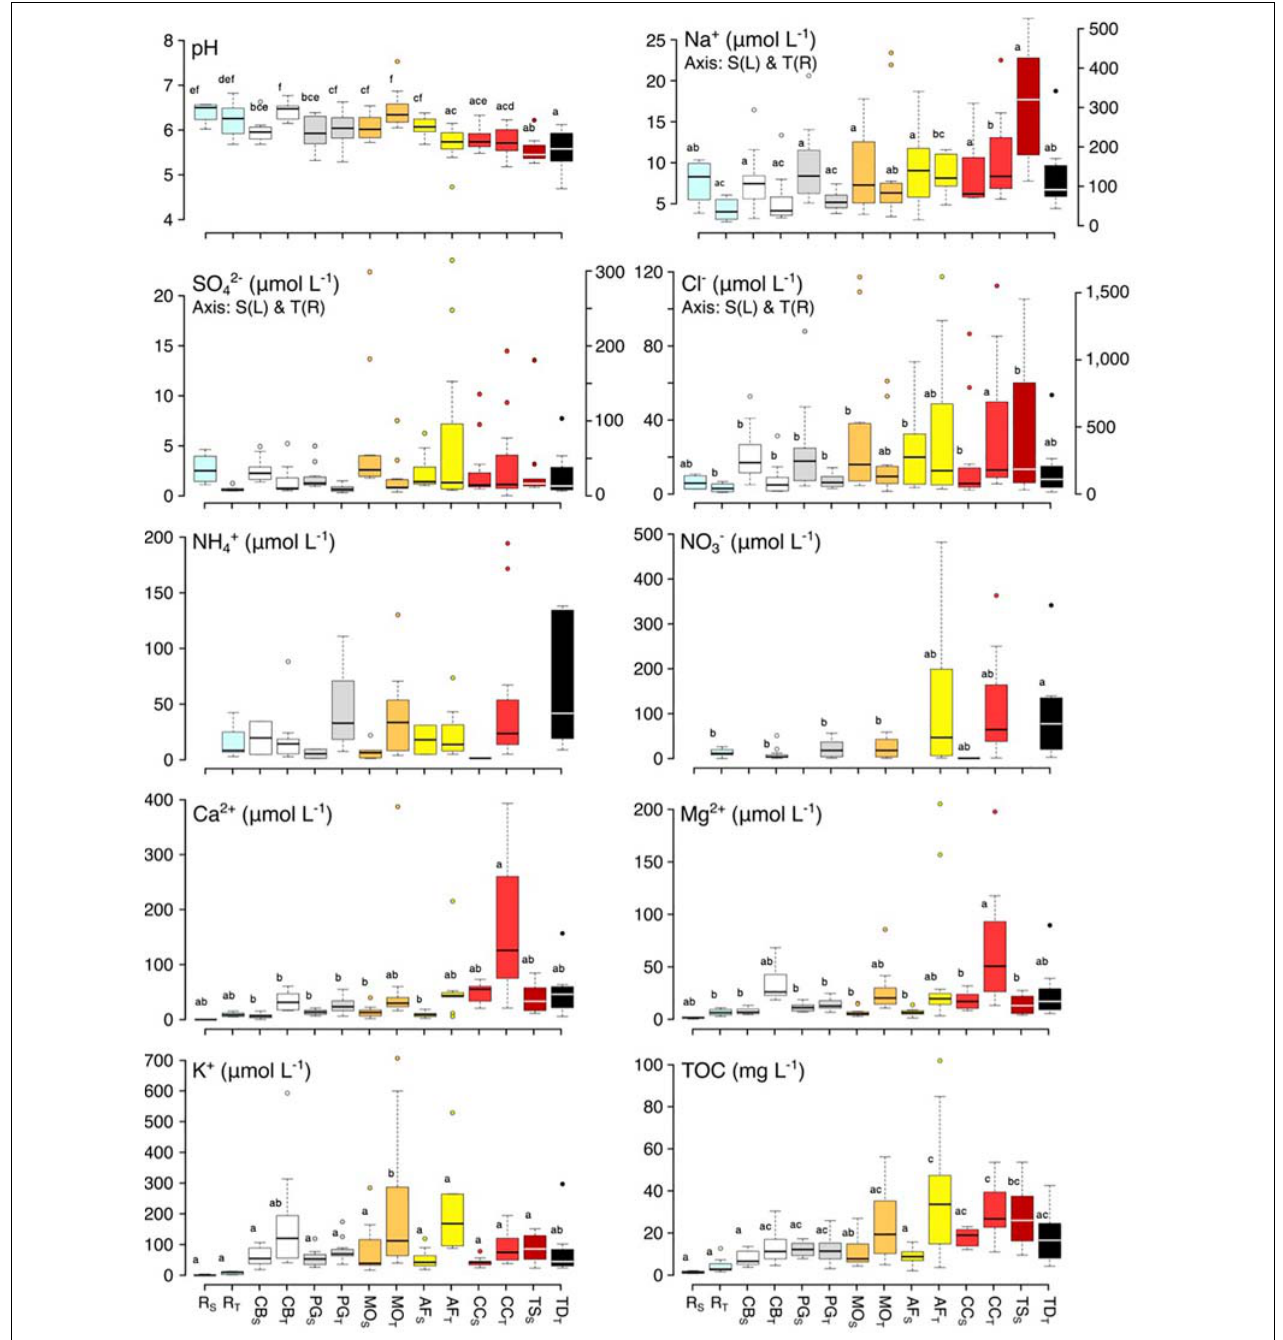
FIGURE 4 | Box-plot of TOC, pH, Cl − , NO 3 − , SO 42 − , Na + , NH 4 + , Mg 2 + , Ca 2 + , and K + concentrations of stemflow by species at foliated and defoliated periods. Species abbreviations are Clethra barbinervis (CB), Padus grayana (PG), Magnolia obovate (MO), Abies firma (AF), Castanea crenata (CC), Tsuga diversifolia (TD), and Tsuga sieboldii (TS). Different letters should indicate significant differences between factor levels. Bars in figure are SD. The letters in the figure mean that there is no difference according to Tukey’s comparison.